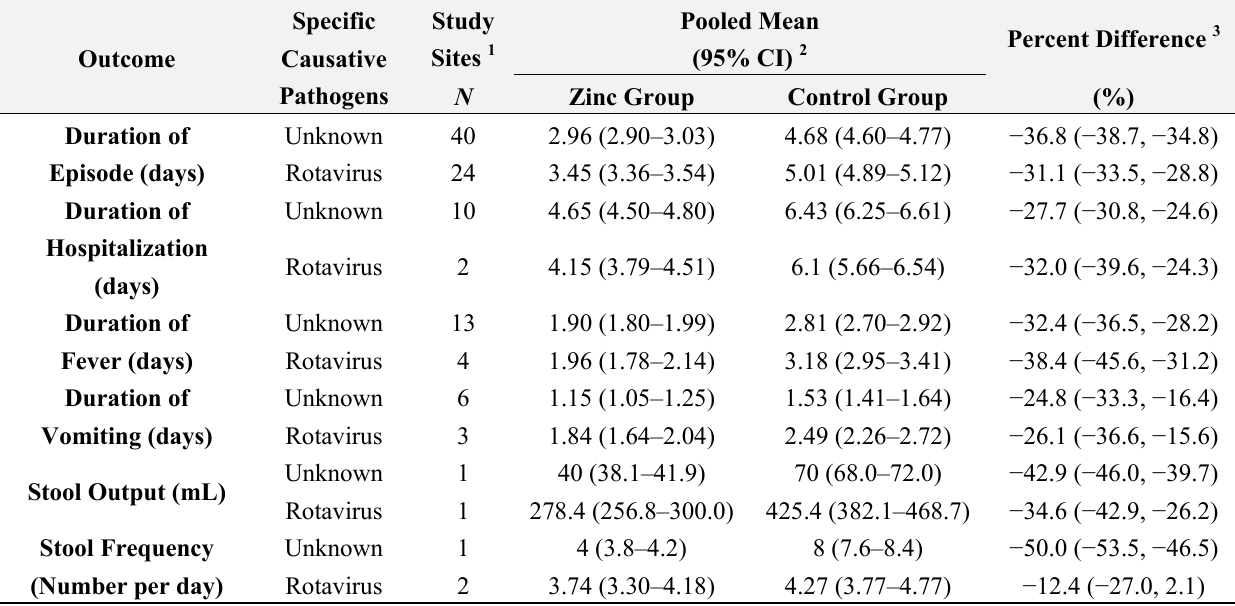
Table 4. Pooled means of select outcomes for Chinese studies.